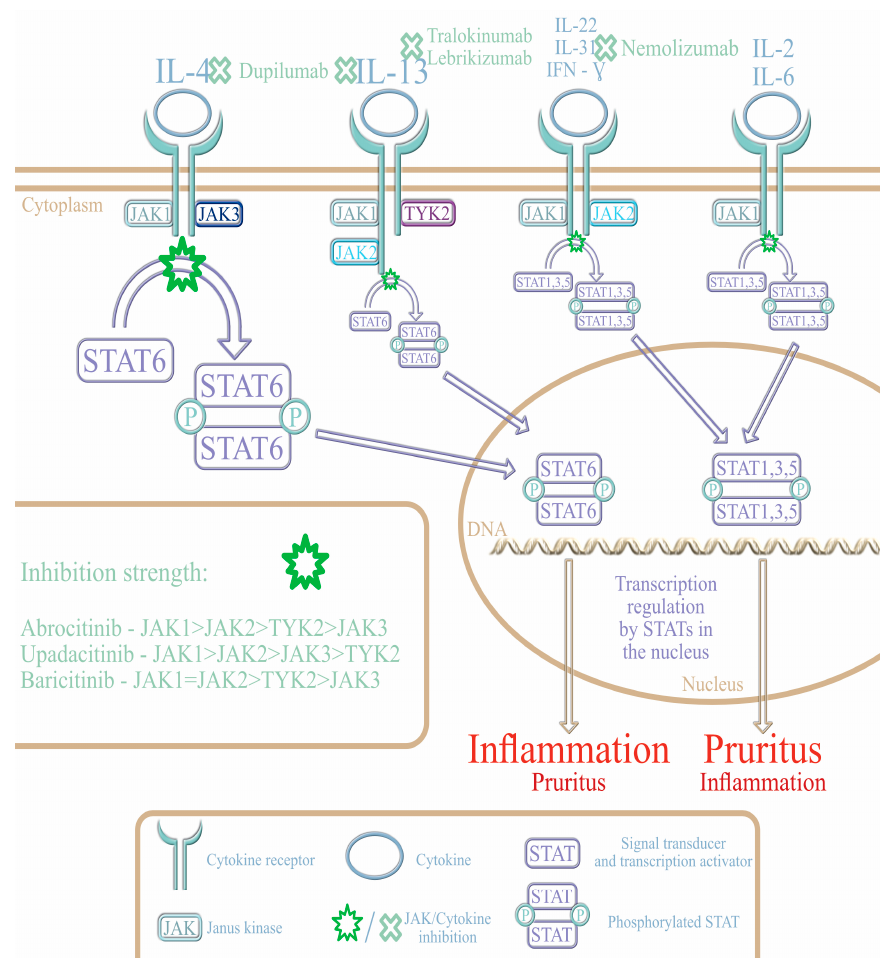
Figure 1. Physiological mechanisms of action of several cytokines important in AD pathophys- iology, which activate Janus kinases (JAKs) to phosphorylate signal transducers and transcrip- tion activators (STATs), have been illustrated. Two pathways, one activated by interleukin-4 and interleukin-13 mostly promoting inflammation and the second stimulated by other cytokines pre- dominantly promoting pruritus, have been shown. Both biological and small molecule inhibitor drugs may block distinct pathways according to their specific place of action—narrower for biolog- ics (dupilumab, tralokinumab, lebrikizumab, nemolizumab) and wider for JAK inhibitors (JAKi) (abrocitinib, upadacitinib,